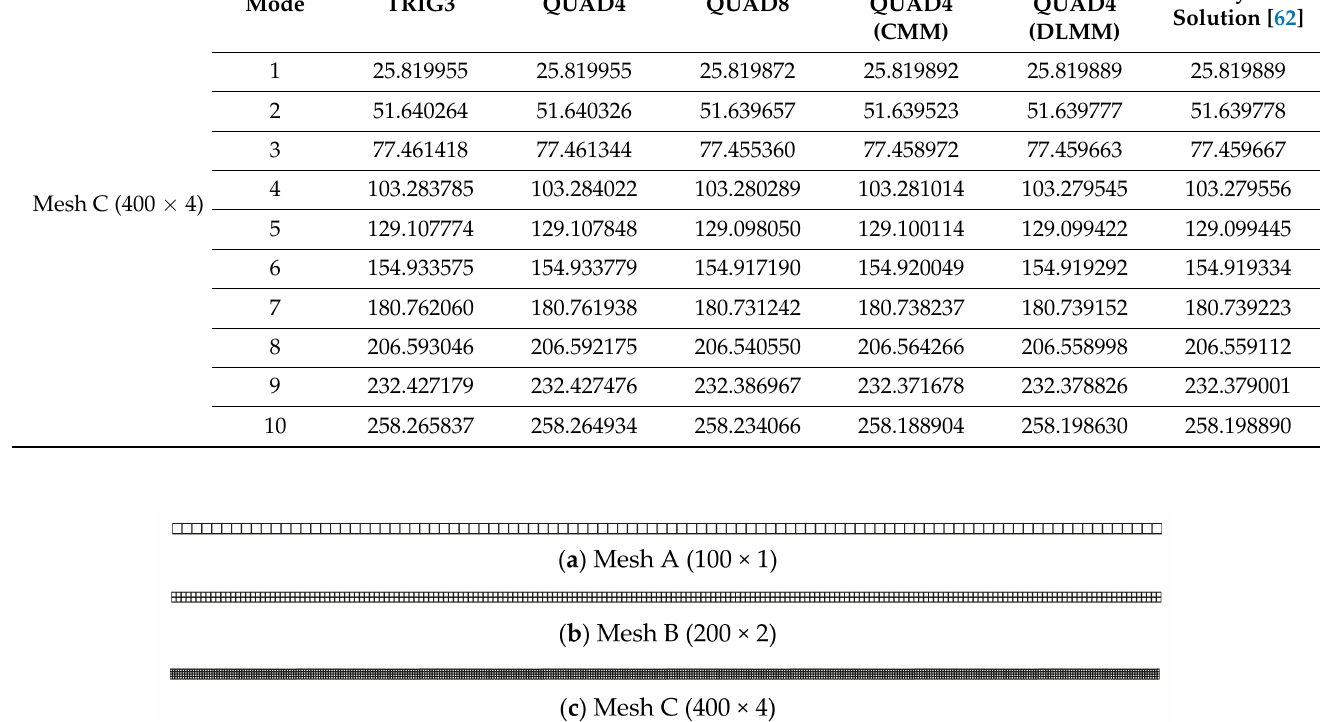
Figure 8. Normalized mesh for slender rod in Figure